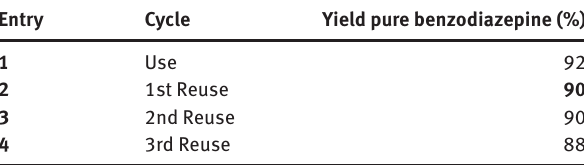
Table 8: Catalyst reuse.